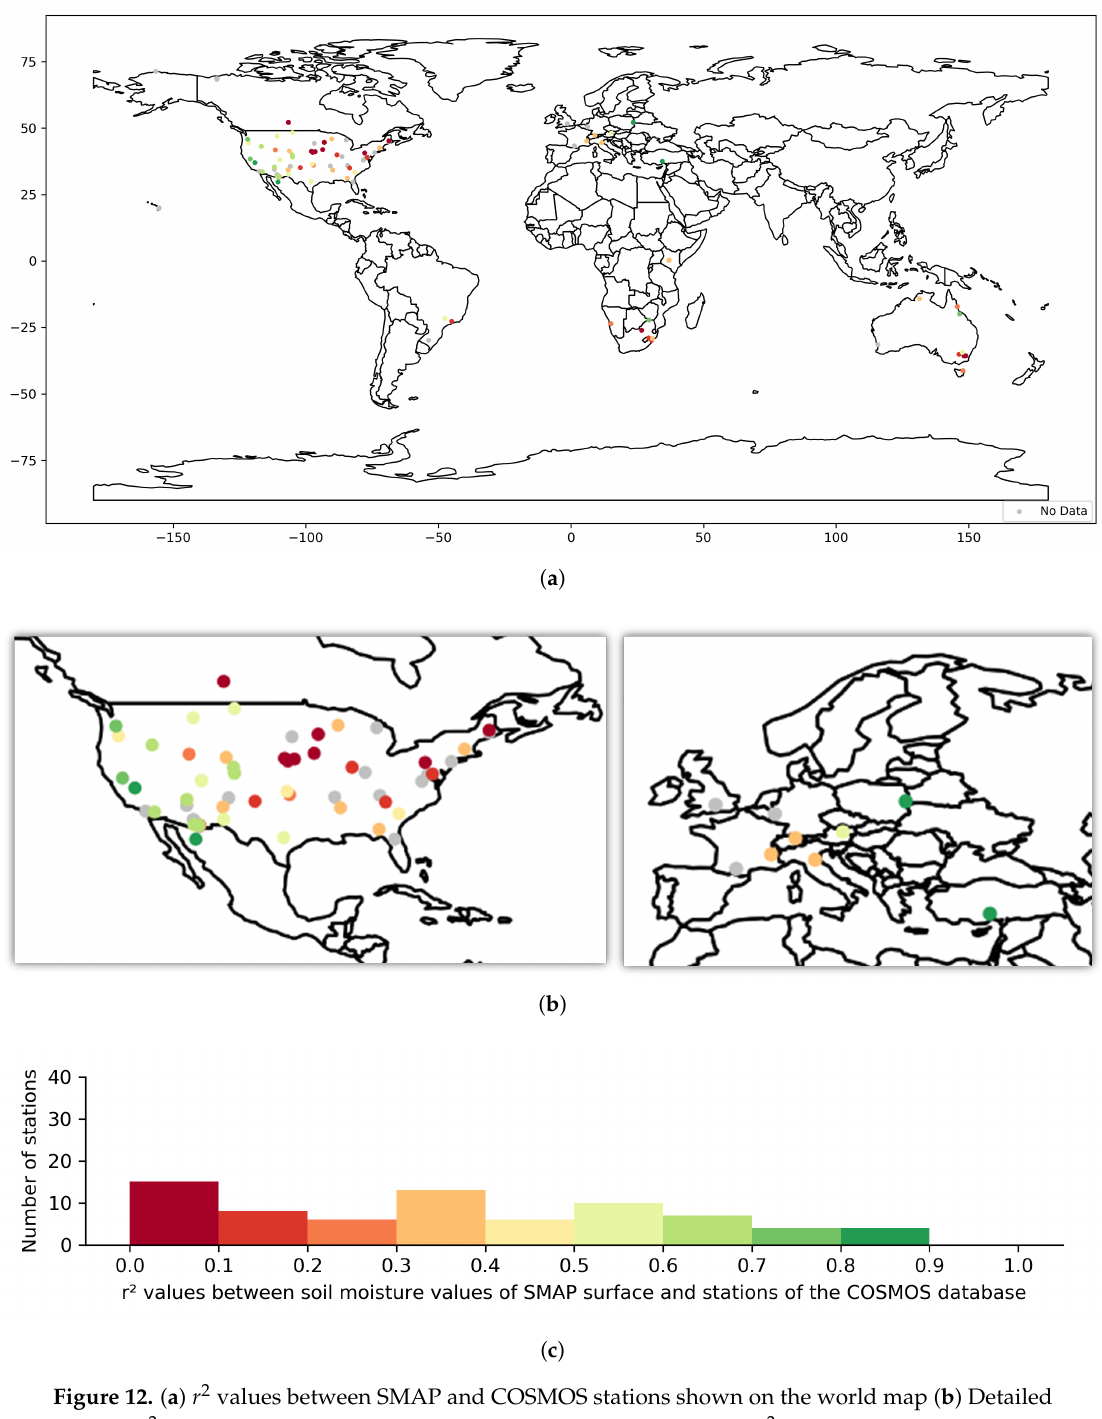
Figure 12. ( a ) r 2 values between SMAP and COSMOS stations shown on the world map ( b ) Detailed maps of r 2 values for the North America and Europe ( c ) Histogram of r 2 values between SMAP and COSMOS